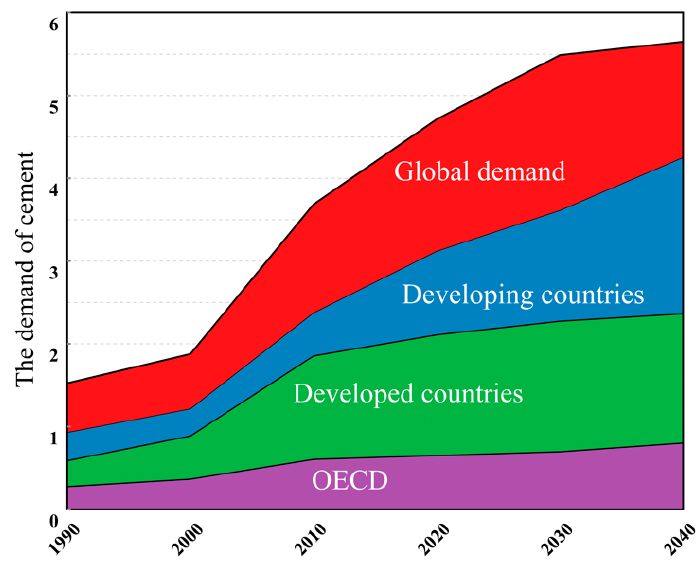
Figure 2. Global cement demand.